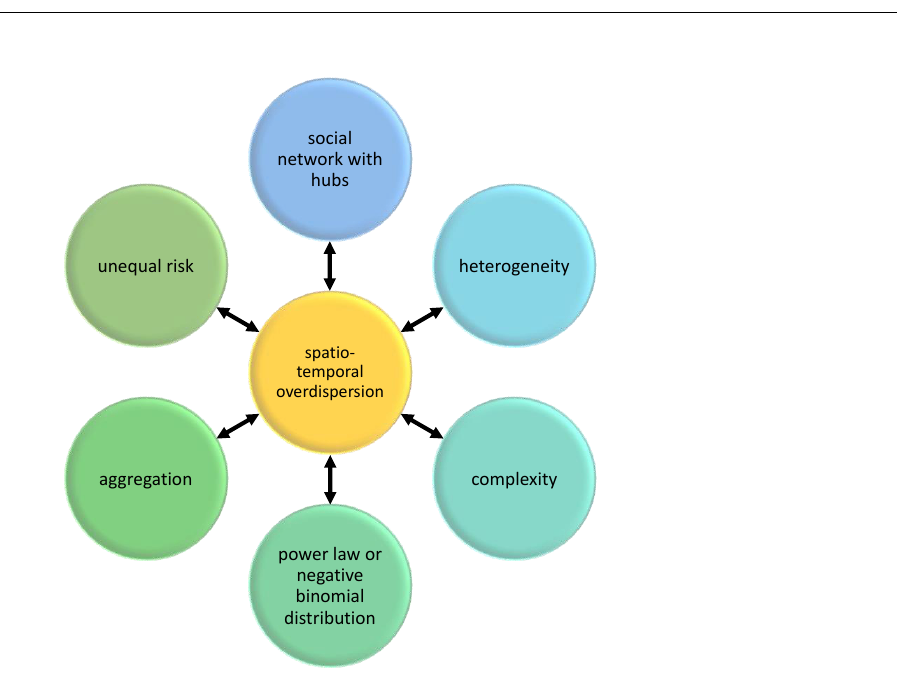
Figure 1. Concepts related to spatiotemporal overdispersion (see Table 1 for the glossary). Each factor can be sufficient to drive parasite load overdispersion in hosts. Social network with hubs, heterogeneity in the characteristics of actors (e.g., hosts), and complexity in host–parasite dynamics may lead to a distribution with variance greater than the mean. This distribution can characterize parasite aggregation in the host population. This aggregated pattern may lead to differential risk, such as superspreading events. These concepts, when investigated, can provide insights about the level of spatiotemporal overdispersion in the system and when tracked, can aid in identifying strategies for infectious disease prevention or control. Overdispersion is the link among concepts presented here. For example, Heterogeneity and Aggregation are both linked to Overdispersion. Table 1. Glossary of terms related to parasite aggregation. These terms, while related to each other, should not be used